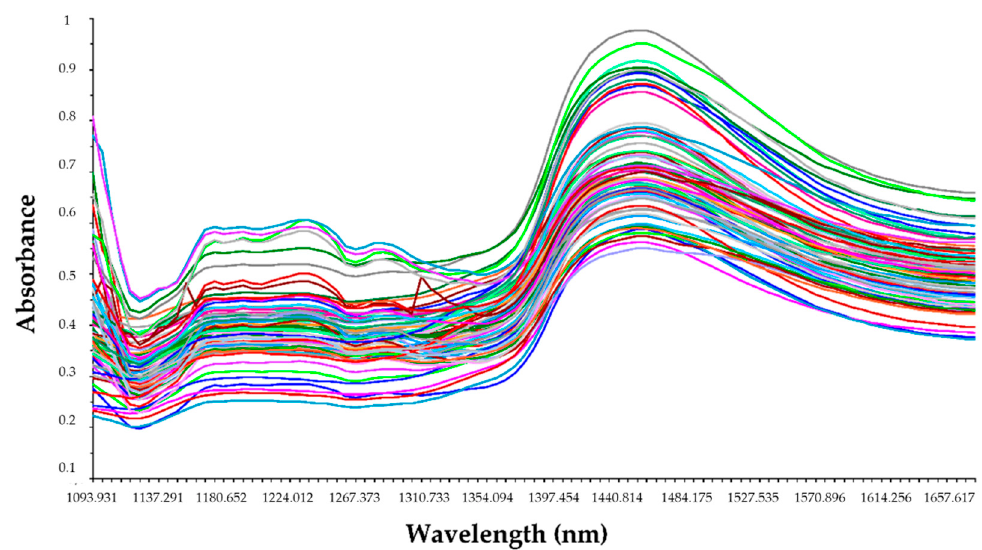
Figure 4. Example of pasture spectra measured with the micro-NIR sensor to predict pasture neutral detergent fibre (NDF) and crude protein (CP).